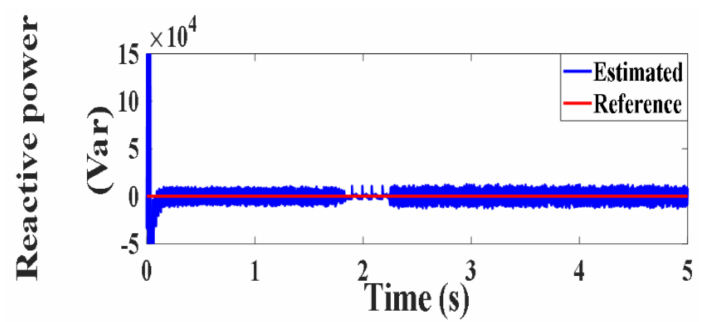
Figure 53. Reactive power under PVC (var).